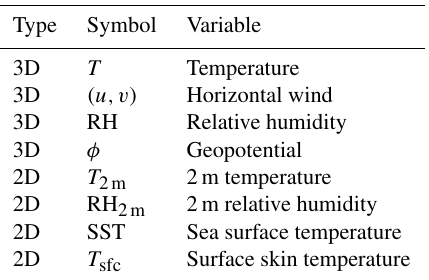
Table 1. Data requirements: pressure-level monthly-mean data from the driving